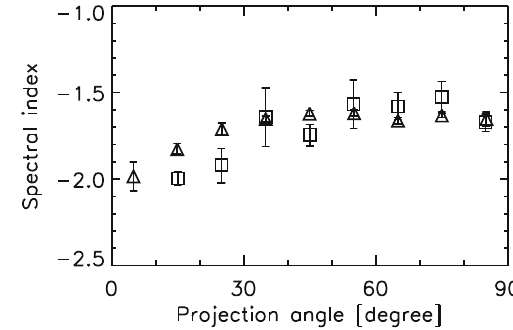
Fig. 2 Spectral index of the one-dimensional energy spectra in the spacecraft-frame frequency domain for turbulent magnetic field fluctuations in the solar wind as a function of the projection angles of the flow direction onto the mean magnetic field: measurements by Horbury et al. (2008) (triangles) and Osman and Horbury (2009)